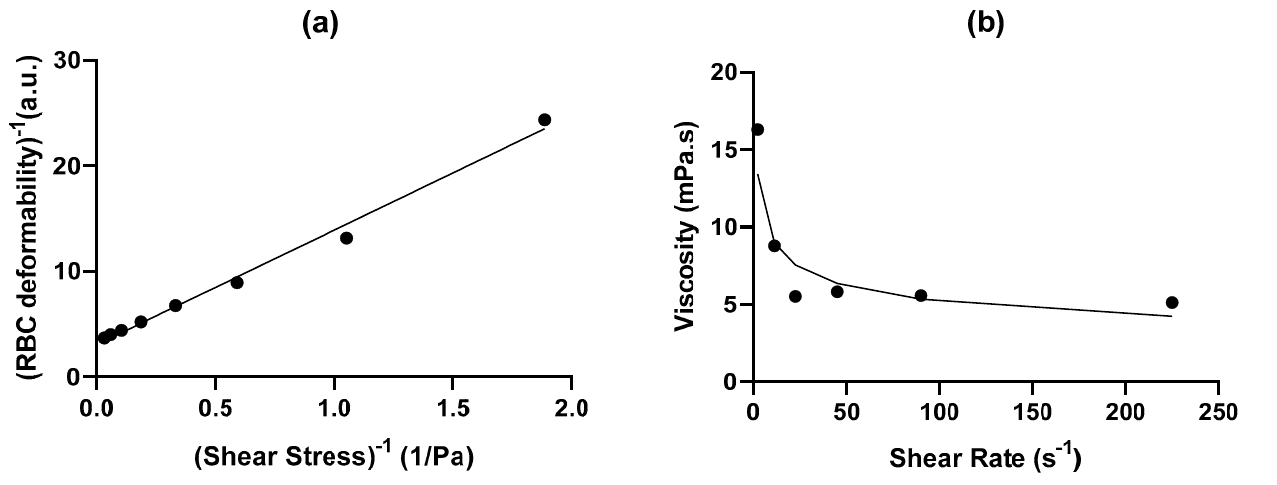
Figure 3. Example of curve fitting for a volunteer with sickle cell anemia (HbSS) with ( a ) Lineweaver–Burke relationship, i.e., inverse deformation as a function of inverse shear stress leading to the personalized function presented in Equation (1), and ( b ) viscosity as a function of the shear rate fitted with power law (Equation (2)).